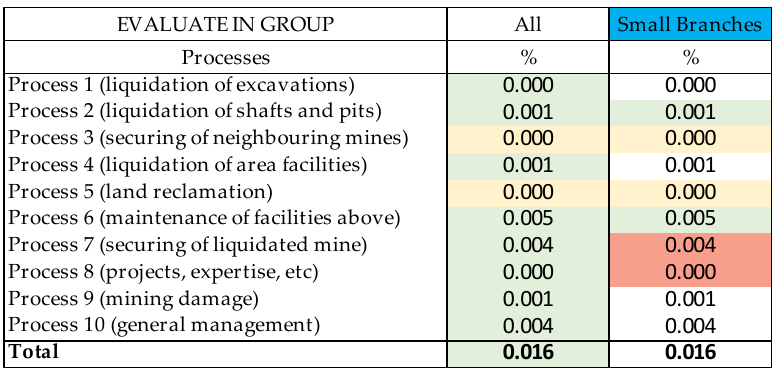
Figure 6. Assessment of the hypothetical branch B19 with minimal value of the liquidation cost of Medium Larger Branches (MLB).